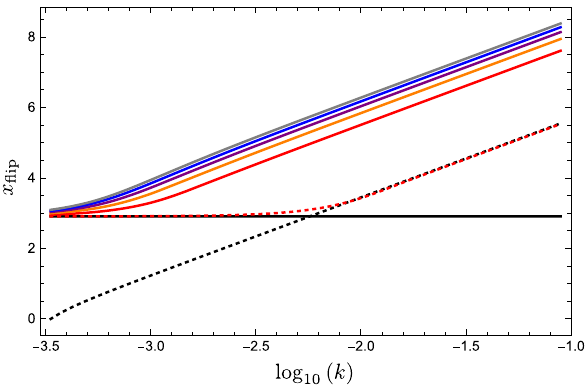
Fig. 6 This figure shows the moment where the gravitational potential switches its sign, x flip , in terms of log 10 ( k ) . Each curve corresponds to = 0 (solid black), a given value of the speed of sound parameter; c 2 s d = 0 . 2 (red), c 2 = 0 . 4 (orange), c 2 = 0 . 6 (purple), c 2 = 0 . 8 c 2 s d s d s d s d = 1 (gray). The red dashed curve corresponds to c 2 = (blue) and c 2 s d s d 2 . 09 × 10 − 3 while the black-dotted line represent the value of x where modes exit the